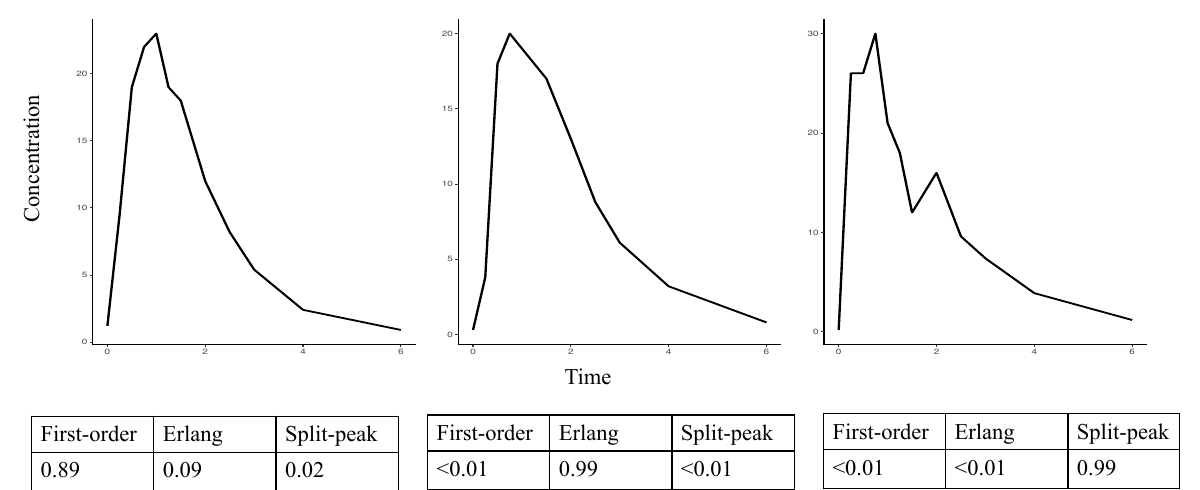
Figure 4. The output of the developed DNN with three examples from the external cortisol data. A difference between the accuracy rate of 93.7% and the uninformative rate of 45.8% was significant ( p < 0.001).